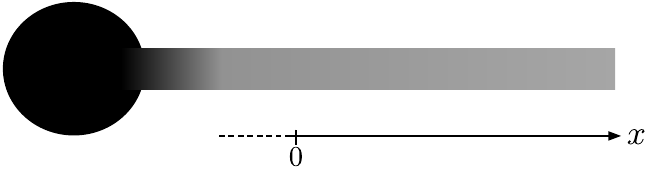
Figure 1 . Mildly noncompact SQFT. The black region is compact and it is connected to the grey region in which the theory is of the form σ ( R ≥ ) ⊗ Y , where σ ( R ≥ ) is the sigma model with the target space R ≥ = { x ∈ R | x ≥ 0 } (i.e. semi-infinite real line) and Y is a compact